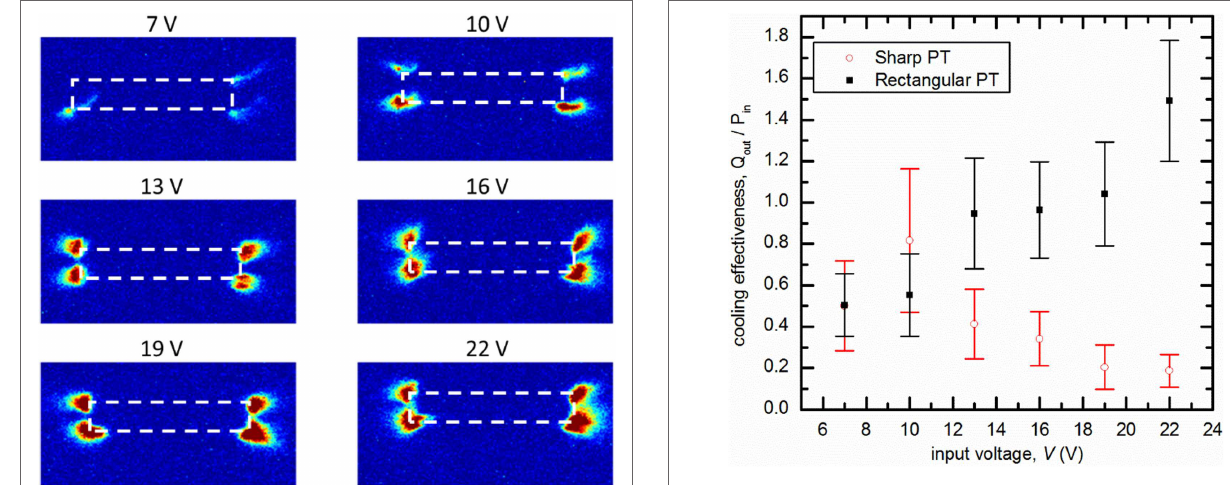
FIGURE 9 | The color intensity of images taken at the end of the PT of the glow forming at the end of the PT from the perspective of the heated plate . The colored patches correspond to the formation of discharges that produce ionic wind jets, while the dashed line represents the location of the piezoelectric.